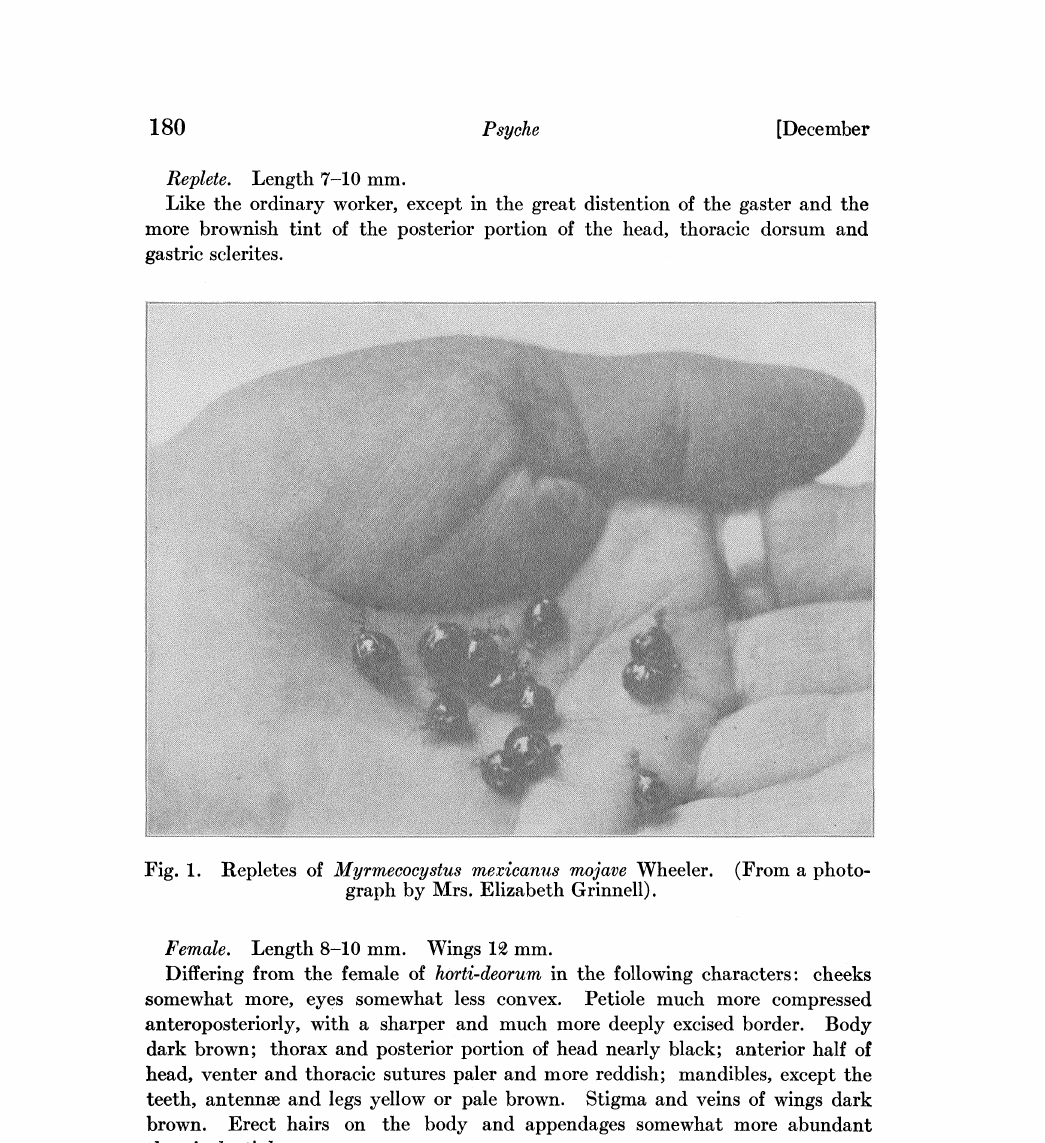
Fig. 1. Repletes of Myrmecocystus mexicanus mojave Wheeler. (From a photo- graph by Mrs. Elizabeth Grinnell). Female. Length 8-10 mm. Wings 1